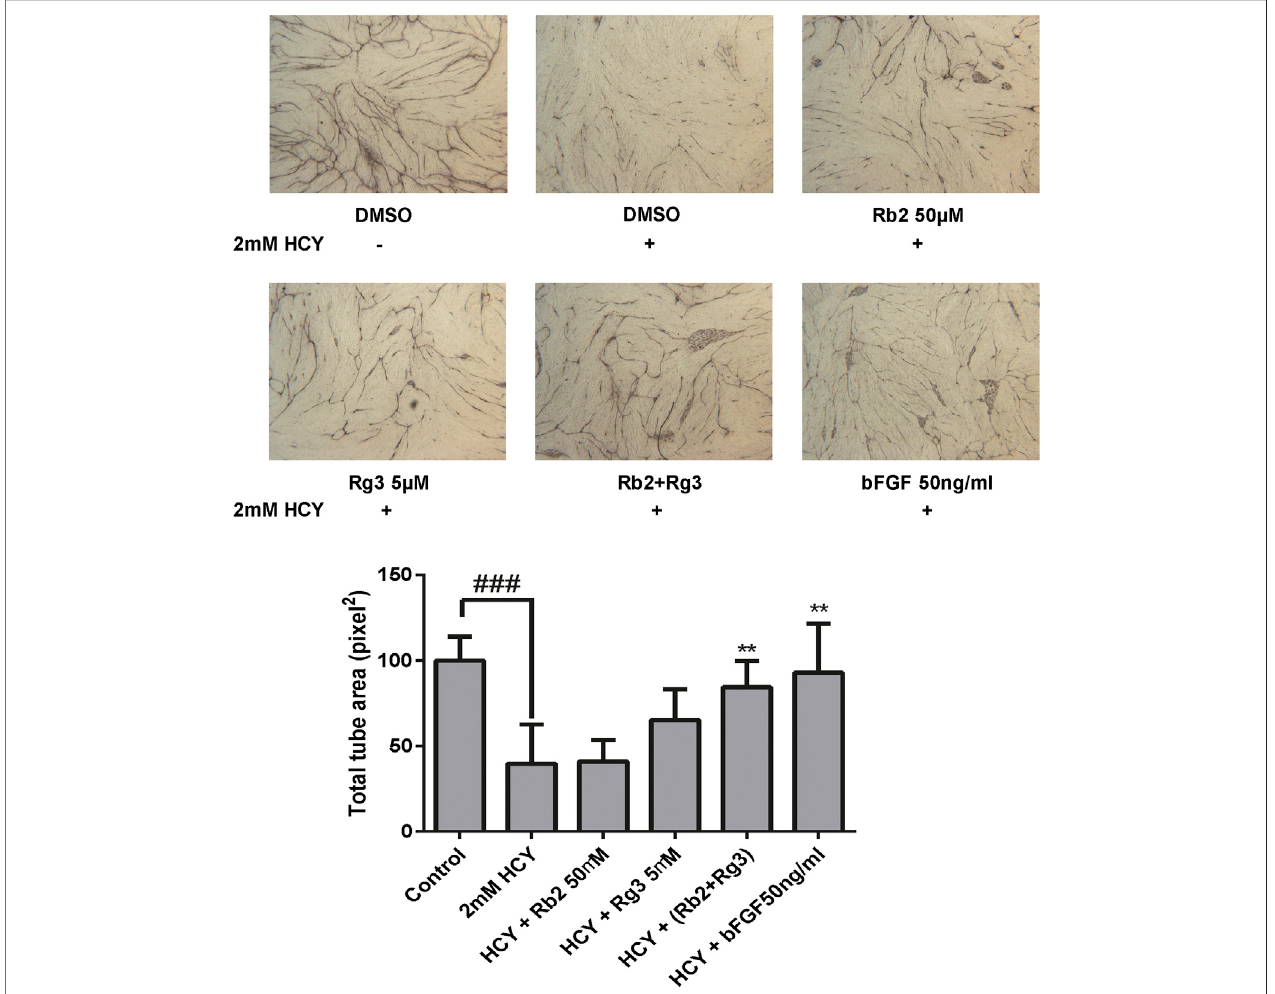
FIGURE 3 | The combination of ginsenosides Rb2 and Rg3 protected endothelial cell tube against homocysteine (HCY)-induced damage in a co-culture tube formation model. The protective effect of the ginsenoside Rb2/Rg3 combination was as good as the positive control FGF. Data represents mean ± SD (n (cid:2) 3). ### indicates p < 0.001; ** indicates p < 0.01 for treatment rescue compared to homocysteine-induced damage (based on tukey ’ s one-way ANOVA).